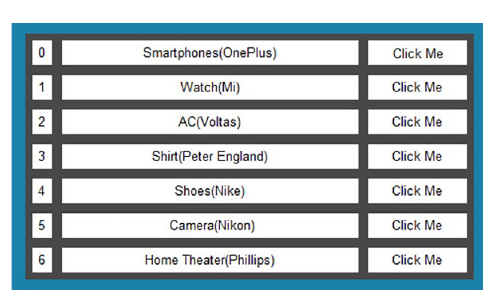
Fig. 7. List of product available